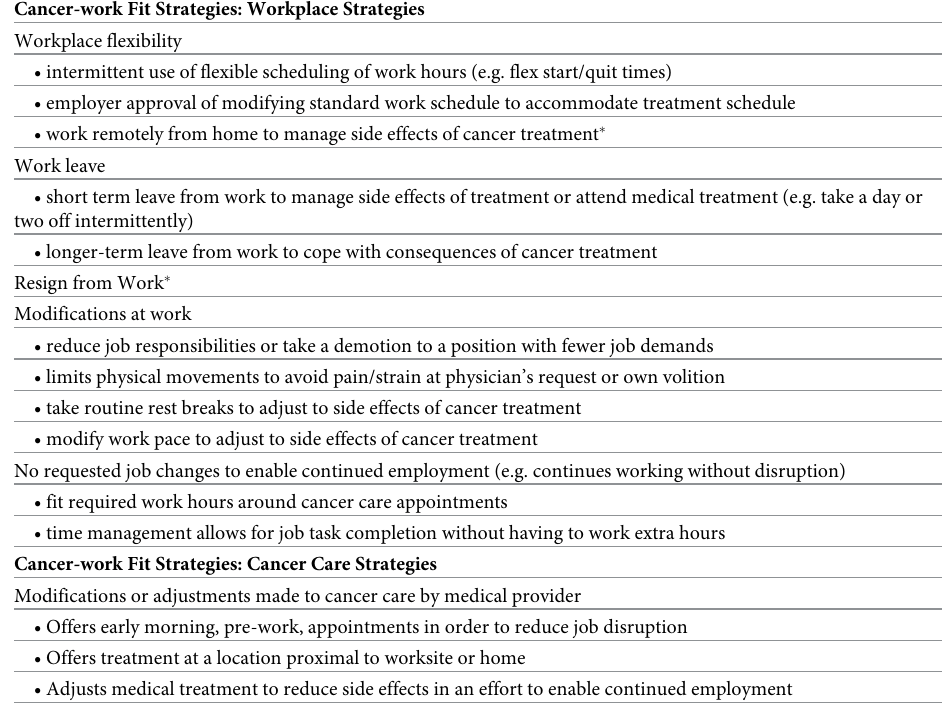
Table 4. Cancer-work fit strategies used by breast cancer survivors with hourly and salary jobs during the first three months of diagnosis by primary and secondary themes (n = 48). Cancer-work Fit Strategies: Workplace